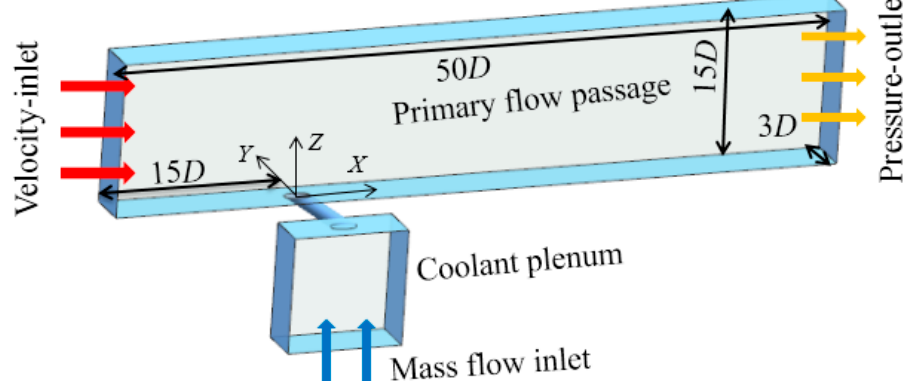
Figure 1. Schematic of computational domain.